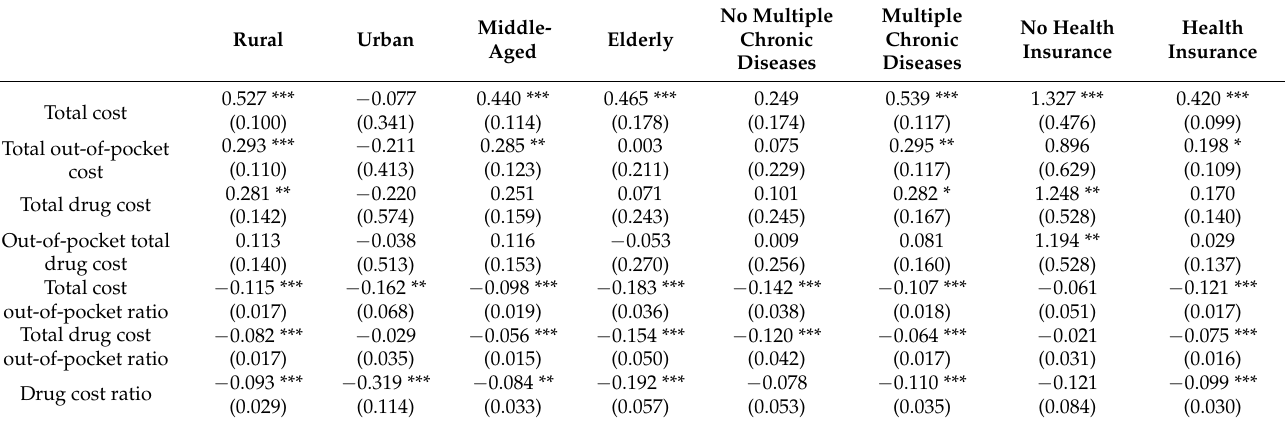
Table 6. Estimated results of the effect of medical choice on health